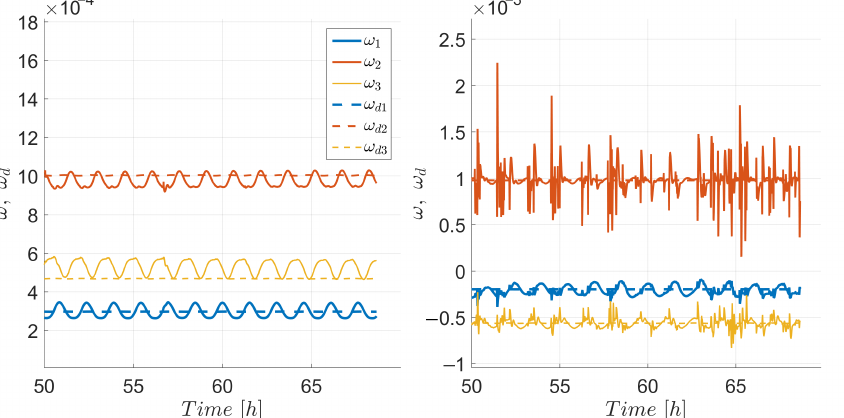
Figure 7. Angular velocities ω and ω d for the target ( left ) and chaser ( right ), last 20 h of